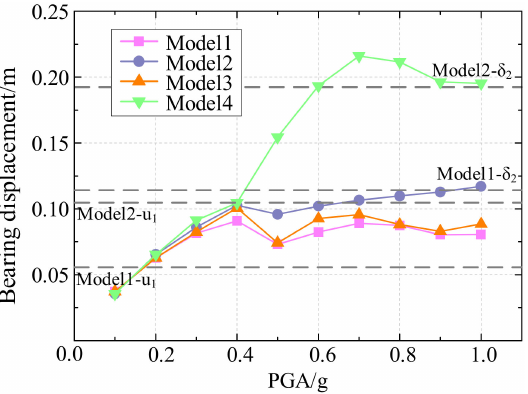
Figure 16. Comparison of bearing displacement demand using diverse bearing